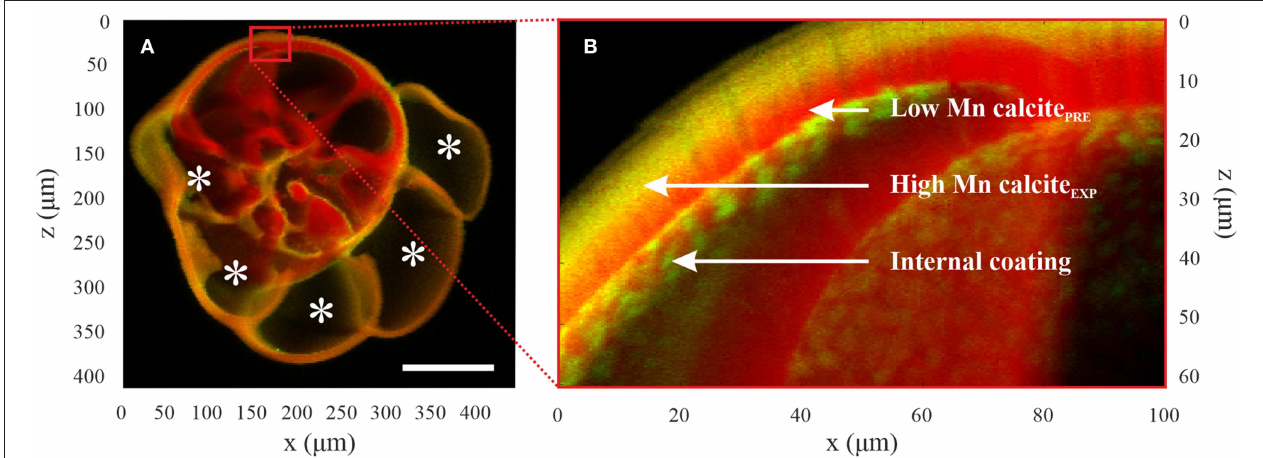
FIGURE 4 | µ XRF elemental maps of Mn (green) and Ca (red) map of a specimen of Ammonia sp. T6 in culture conditions (Aq600). (A) Overview map; the five calcified new chambers are noted with an asterisk. They are enriched in Mn compared with chambers calcified prior to the experiment, and there is coverage of the entire test with enriched Mn calcite from the experiment. Scale bar is 100 µ m. (B) The magnified image shows three locations of interest that have been defined for the µ XANES analyses: calcite formed in enriched Mn stable conditions (“high Mn calcite EXP ”), calcite formed prior to the experiment (“low Mn calcite PRE ”), and internal coating. µ XRF, micro-X-ray fluorescence; µ XANES, micro-X-ray absorption near-edge structure.